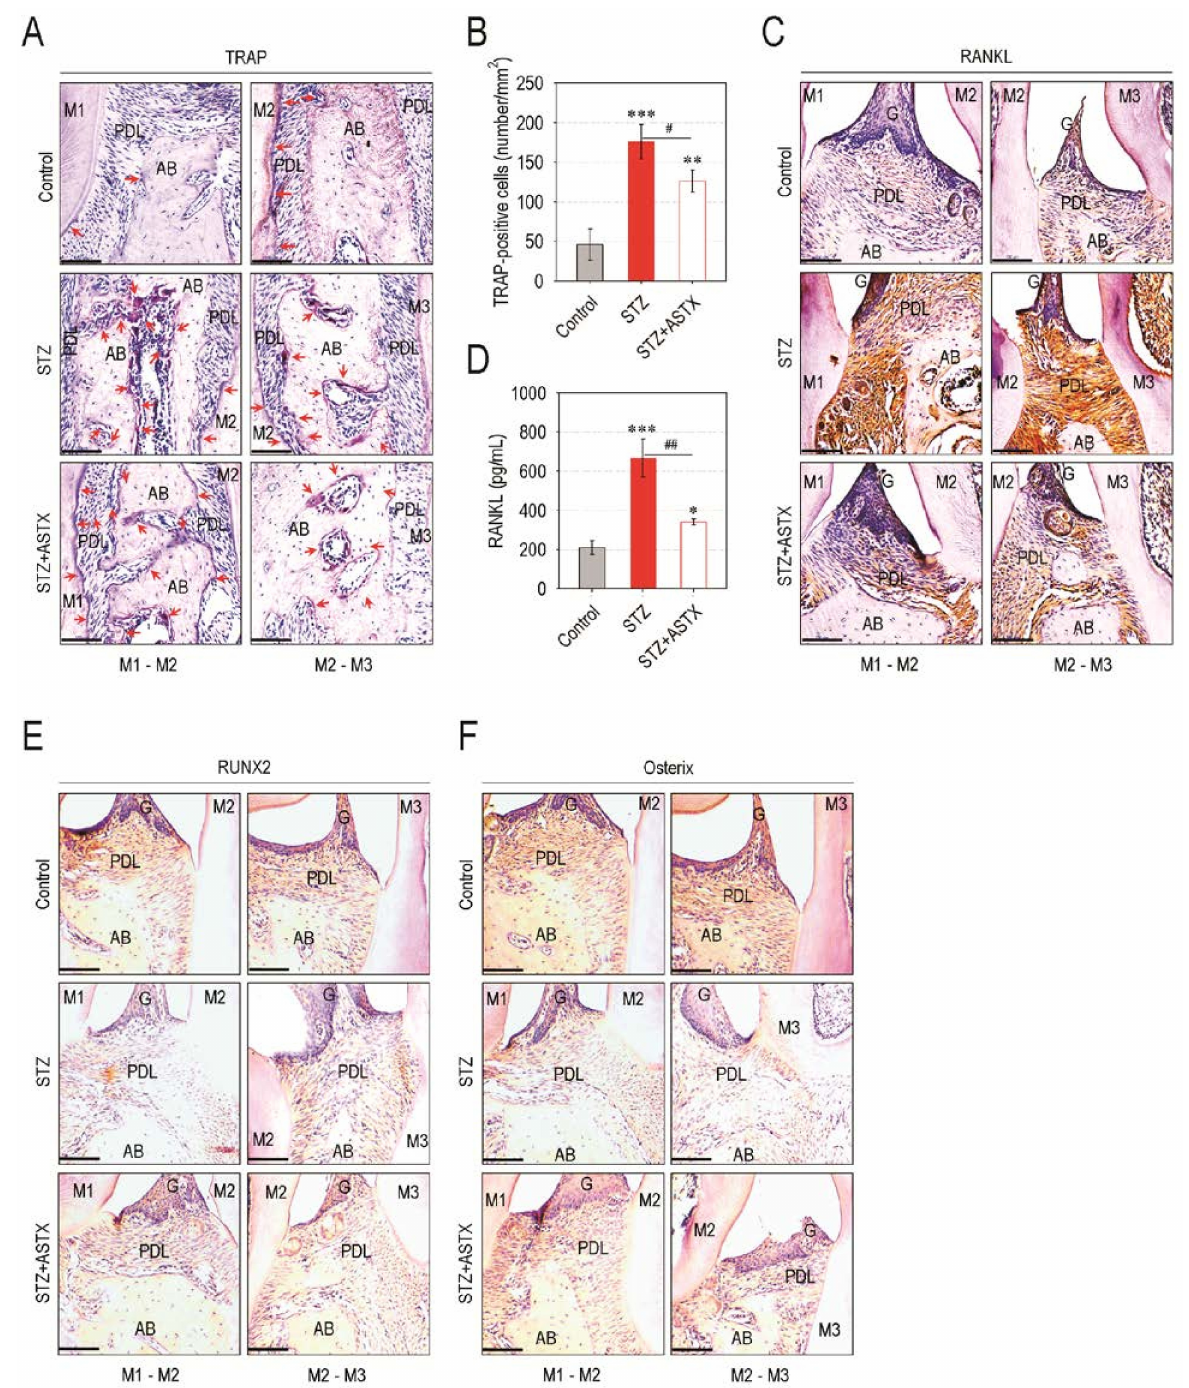
Figure 4. Oral gavage with ASTX restores hyperglycemia-associated imbalanced activation between osteoclasts and osteoblasts in STZ-induced diabetic mice. ( A ) TRAP staining showing osteoclast formation in the interproximal region of maxillary molars (M1 to M3) at 60 days post-hyperglycemia induction (200 × magnification). Bar = 100 µ m. The red arrows indicate TRAP-positive osteoclasts. ( B ) Area of the TRAP-positive cells (mm 2 ) was determined using ImageJ program ( n = 6). ( C ) IHC staining exhibiting the expression level of RANKL at the region of upper molars (200 × magnification). Bar = 100 µ m. ( D ) The level of RANKL in blood serum of mice groups was determined by ELISA 60 days after hyperglycemia induction ( n = 6). Levels of ( E ) RUNX2 and ( F ) osterix in the maxilla were also evaluated by IHC at the same time (200 × magnification). Bar = 100 µ m. * p < 0.05, ** p < 0.01, and *** p < 0.001 vs. control group; # p < 0.05 and ## p < 0.01 vs. STZ